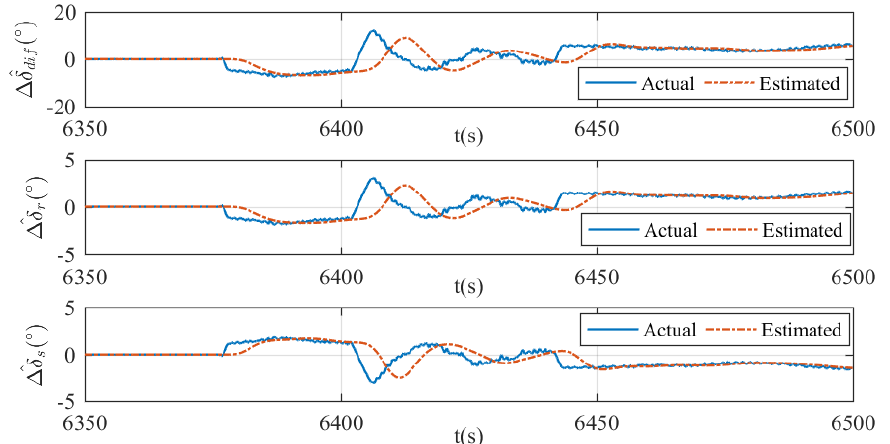
Figure 19. Estimation of ∆ u in case 1. The estimated di ff erential angle (top), the estimated virtual vertical rudder angle (middle), and the estimated virtual horizontal rudder angle (bottom).